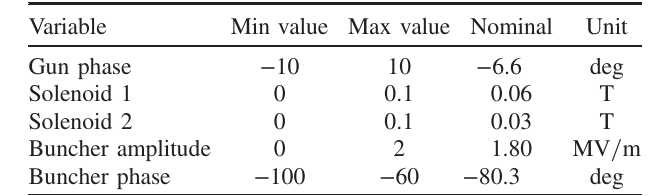
TABLE II. Comparison of models for SPEAR3 simulation data.